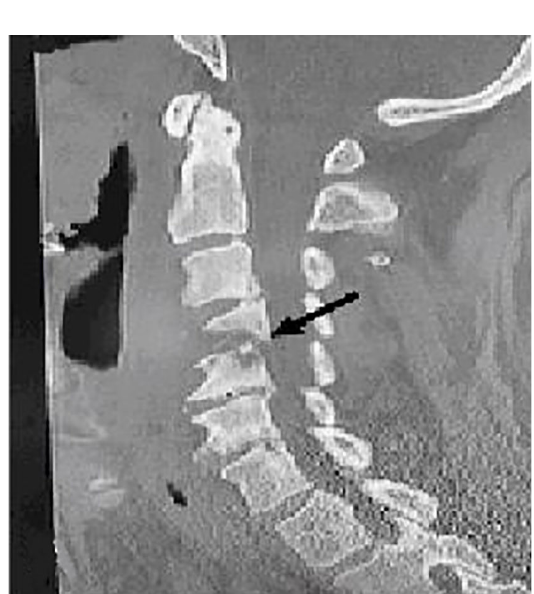
Image 1. Computed tomography scan of sagittal plane of cervical spine showing fourth and fifth cervical osteomyelitis (arrow) upon